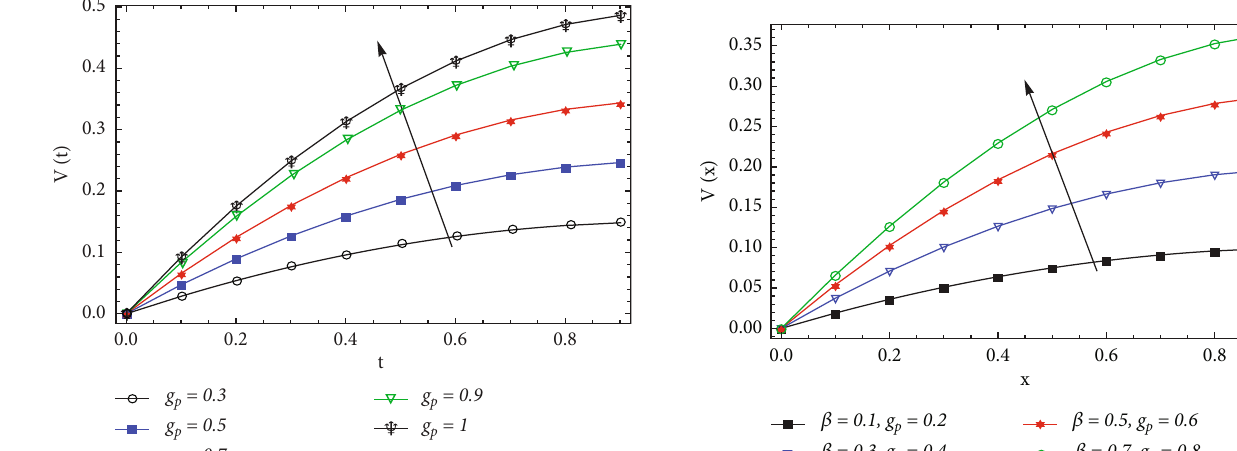
on V ð x Þ keeping α = 0 : 95 p